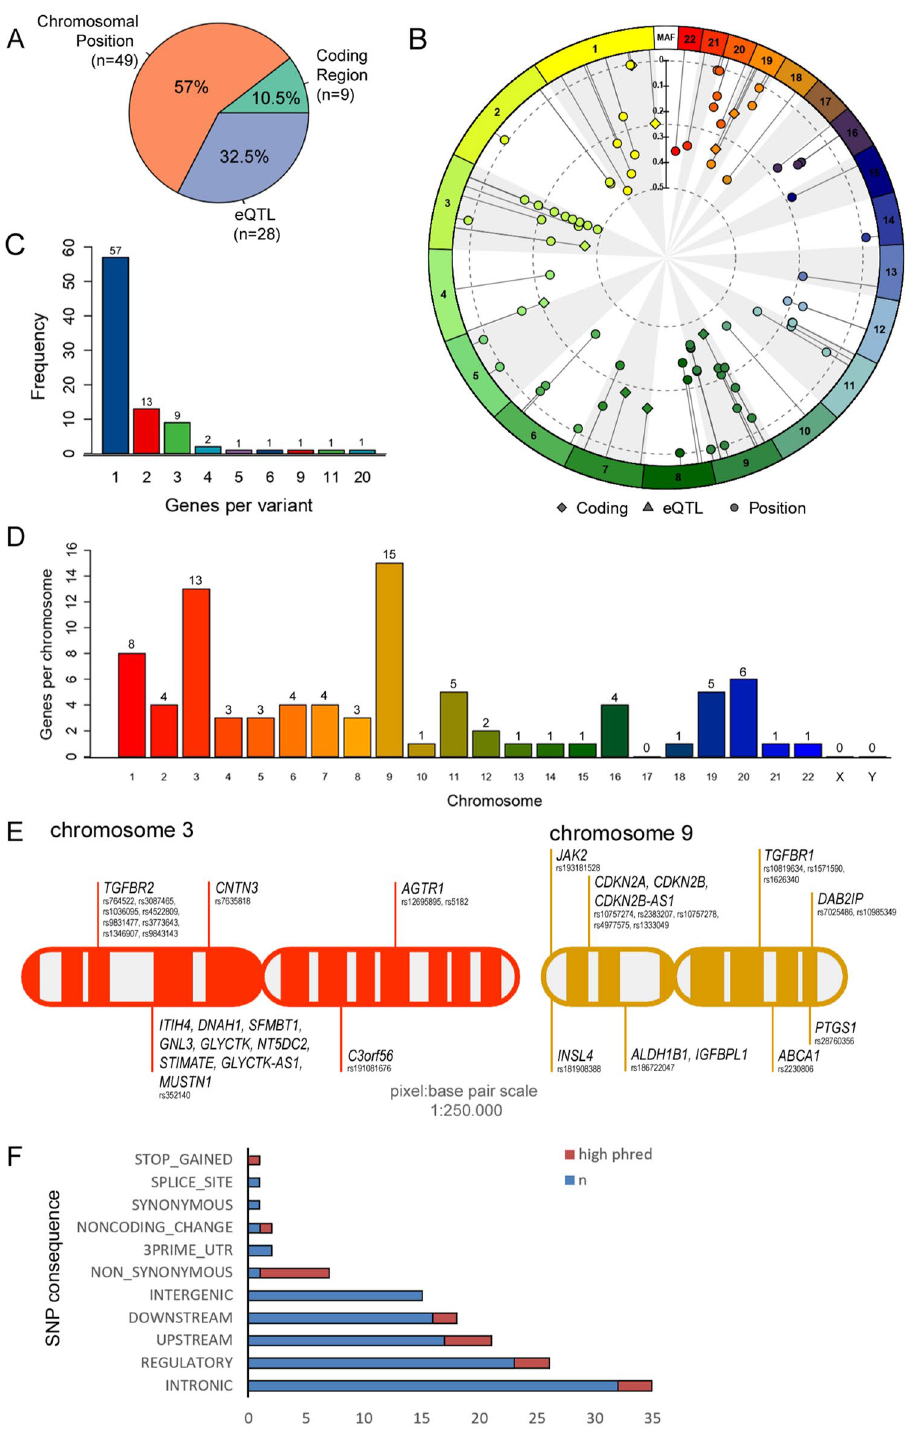
Figure 2. Genome Distribution of 86 SNPs Associated with AAA. ( A ) Most of the identified SNPs were annotated based on their chromosomal position (n = 49), followed by GTEx tissue expression (n = 28) and direct gene coding (n = 9). ( B ) The frequency of genes per genetic variant identified in this study. ( C ) The circular plot analyzed using snpXplorer AnnotateMe tool visualized the annotation type of each genetic variant (coding region, eQTL, or their positions) and their respective minor allele frequency and chromosomal distribution. ( D ) Distribution of SNPs across different chromosomes, with chromosome 3 and 9 having more AAA-related SNPs. ( E ) The complete SNP chromosome mapping of chromosome 3 and 9 as the top two locations of SNPs in AAA using a scale of 1:250,000 scale of pixels. ( F ) SNPs associated with AAA most commonly reside in their respective gene’s intronic, regulatory, upstream, downstream, or intergenic